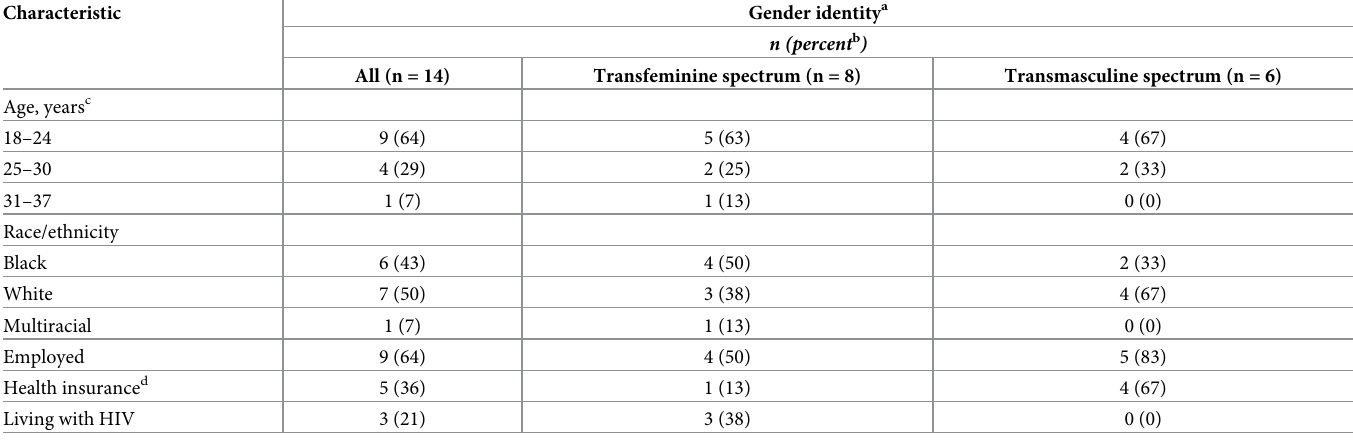
Table 1. Demographic characteristics of transgender study participants in Jackson,